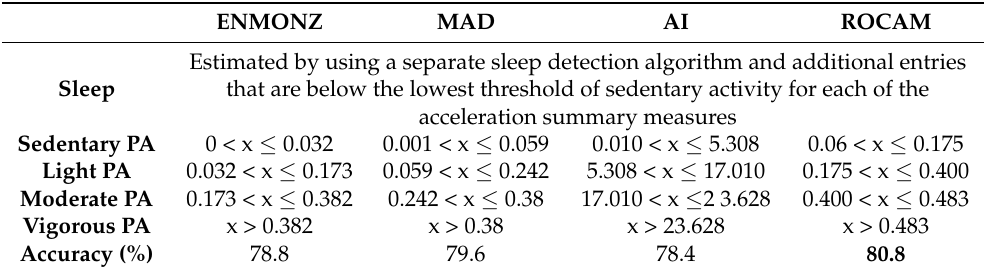
Table 2. Thresholds to differentiate the different PA categories for the four acceleration summary measures and resulting accuracy with accelerometry data sampled at 10 Hz. ENMONZ MAD AI ROCAM Estimated by using a separate sleep detection algorithm and additional entries Sleep that are below the lowest threshold of sedentary activity for each of the acceleration summary measures Sedentary PA 0 < x ≤